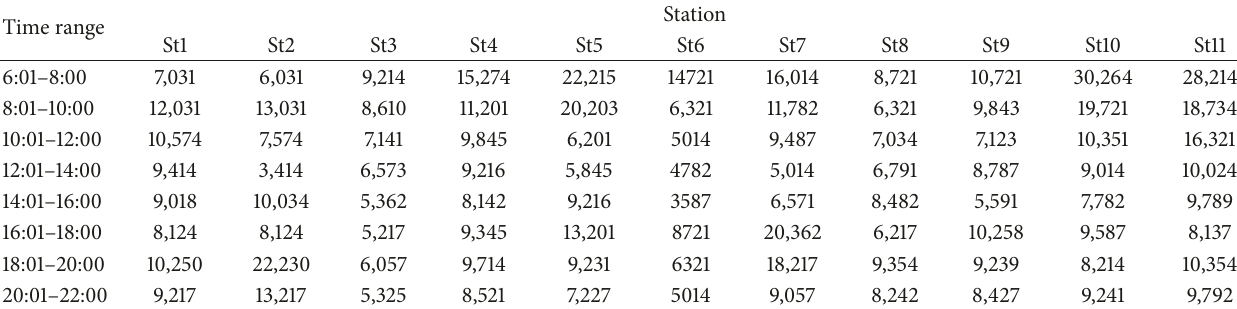
Table 4: The aggregation passenger flow based on distribution